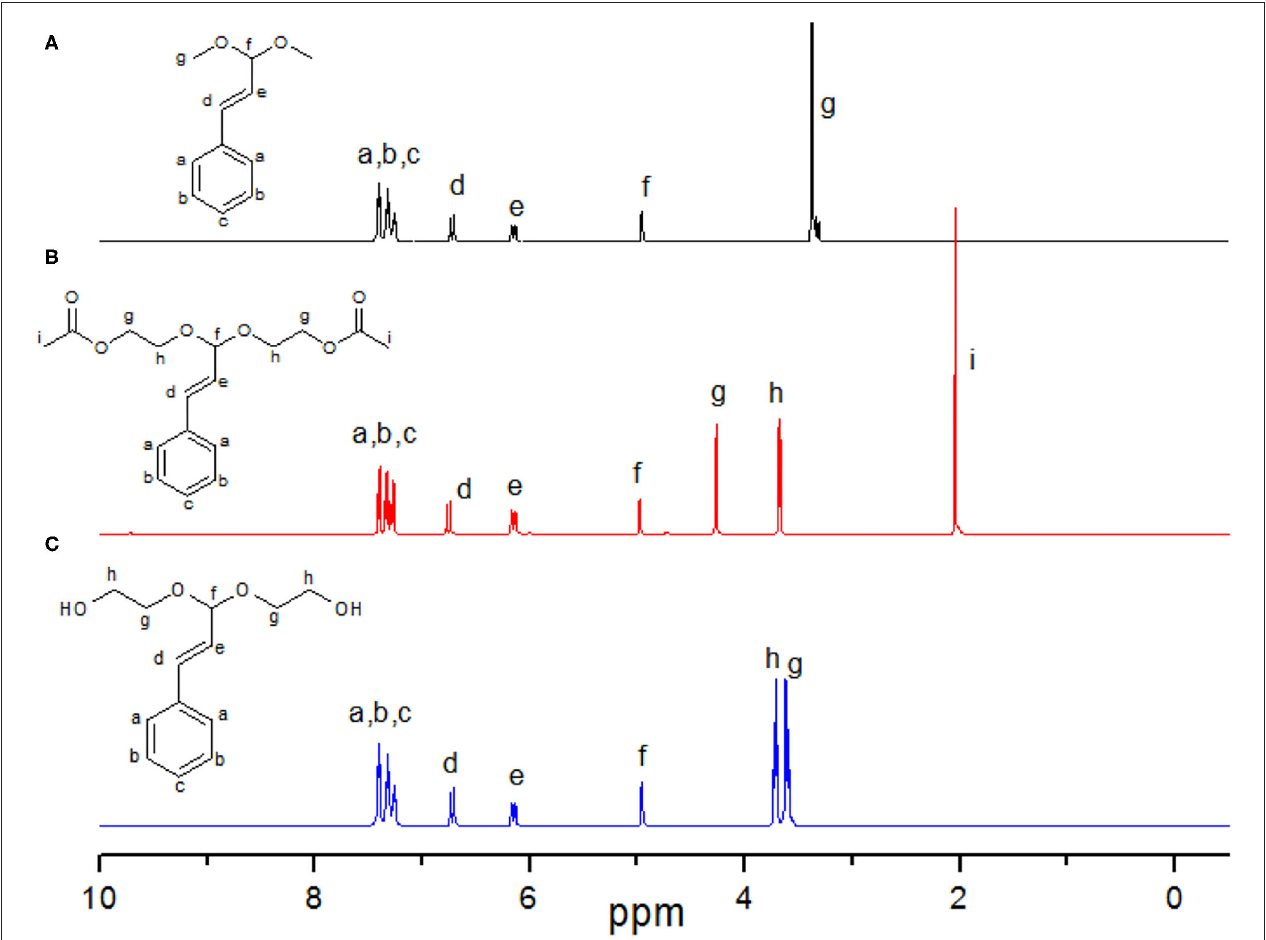
FIGURE 1 | 1 H NMR spectra of initiator CADEG (C) and its two precursors (A,B) in CDCl 3 .